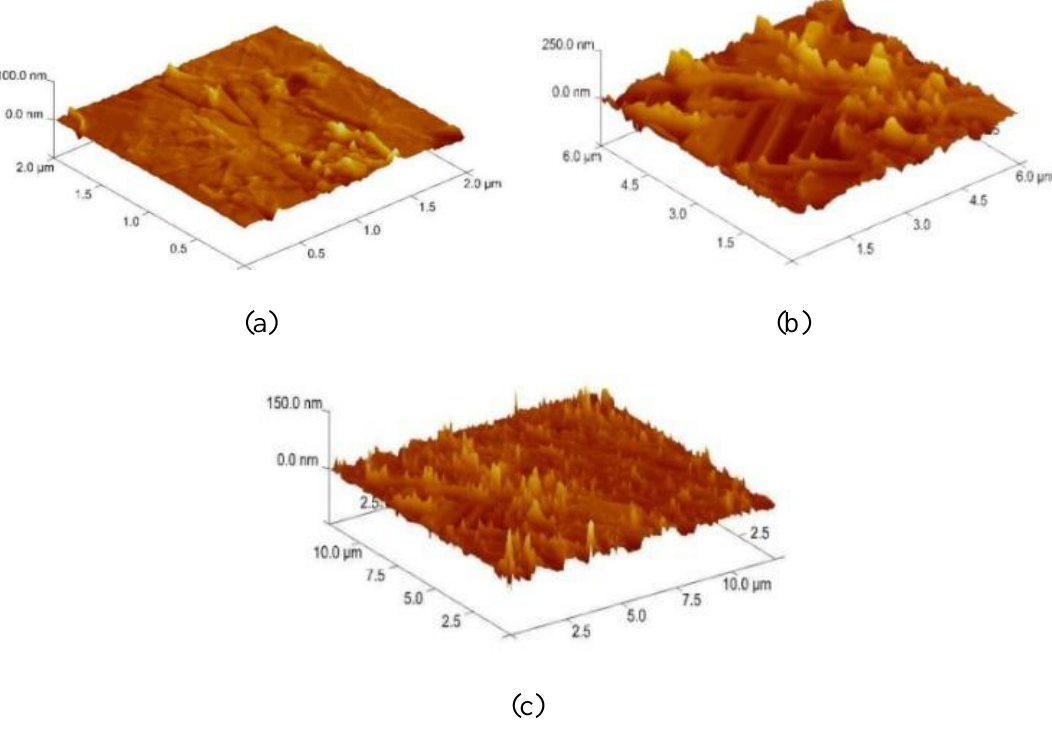
Figure 8. Three dimensional Deflection images for different scan sizes for GC435 coated carbide inserts of (a) 2 μm; (b) 6 μm and (c) 12 μm.